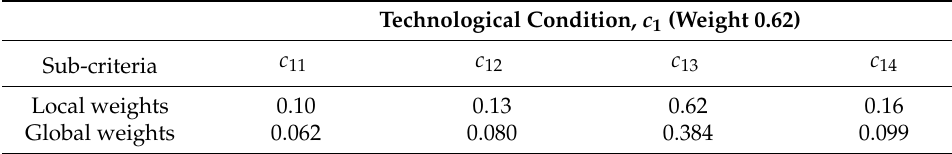
Table 8. Weights of sub-criteria related to the technological condition.